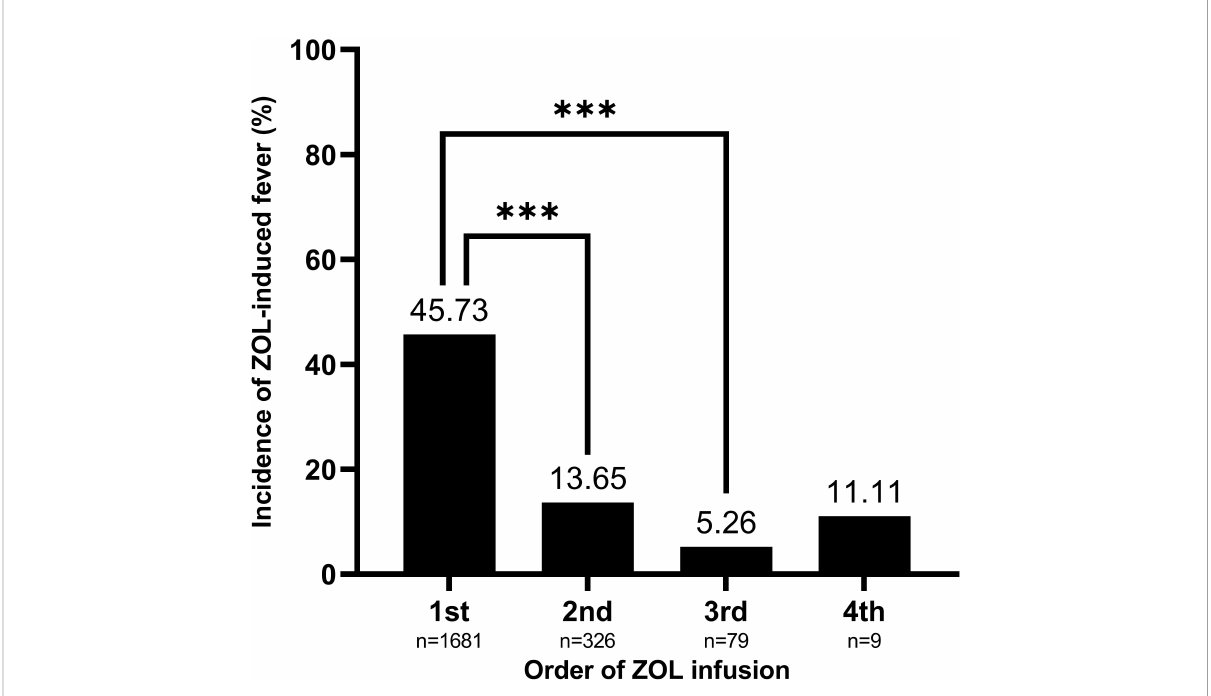
FIGURE 3 The order of ZOL infusion depicting a signi fi cantly negative association with ZOL-induced fever risk. Data are presented as mean. *** P -value<0.0001 as indicated. ZOL, zoledronate.